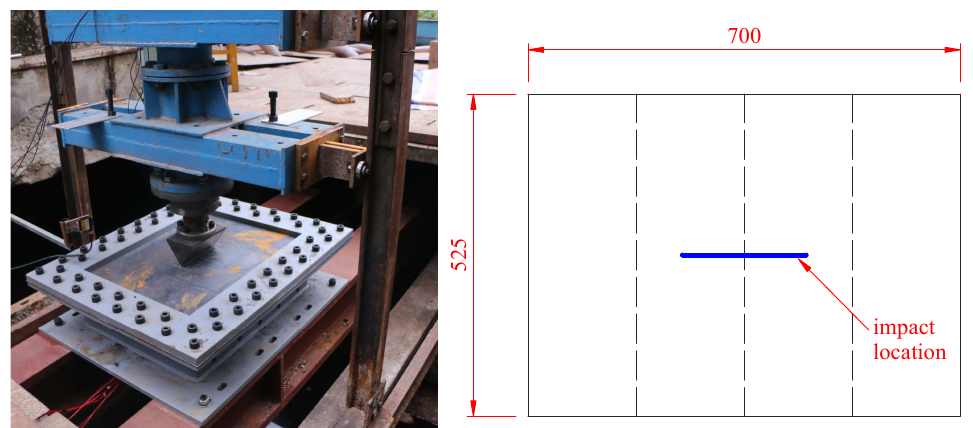
Figure 8. Centric impact scenario: impact at the center of the stiffened plate.